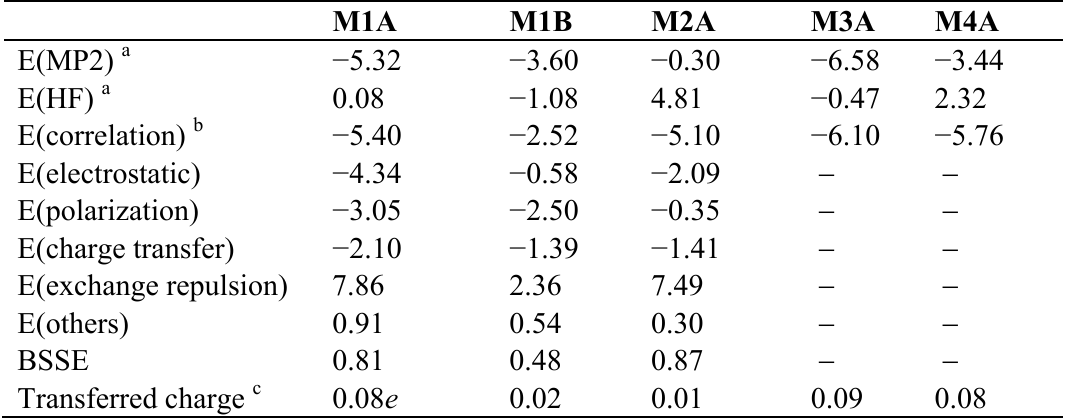
Table 2. Interaction energies (kcal/mol) and transferred fractional charges for the interacting pair